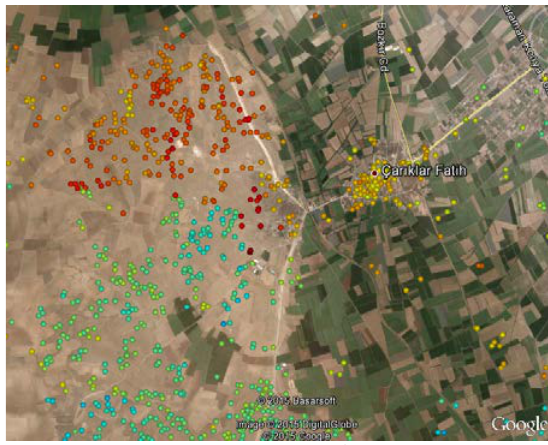
Figure 10. GPS network on study area with sinkholes and fault lines